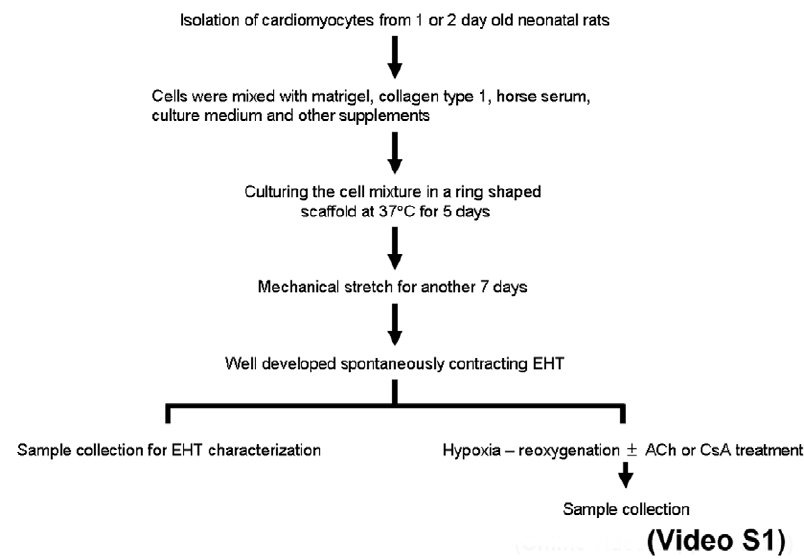
Figure 1. Experimental Protocol. Experimental protocol of the study.